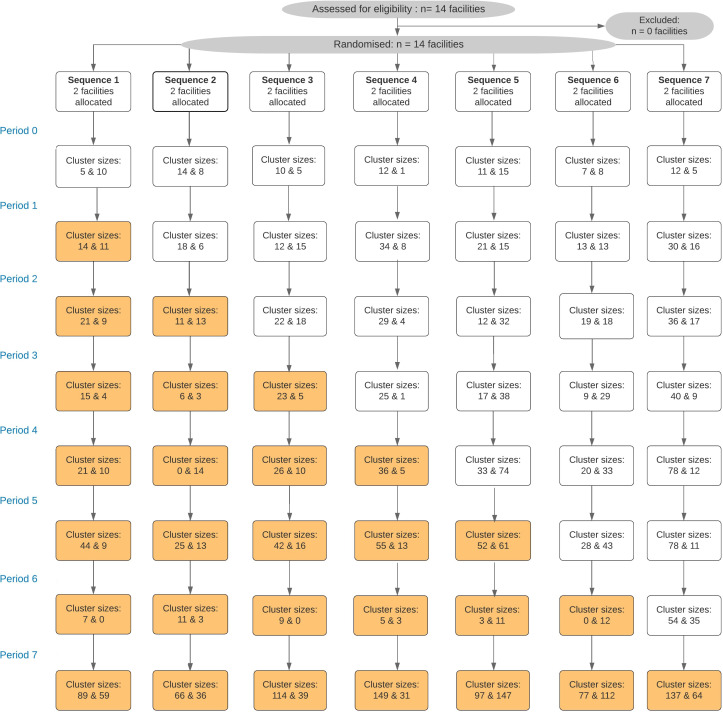
Participant flow chart (full sample).